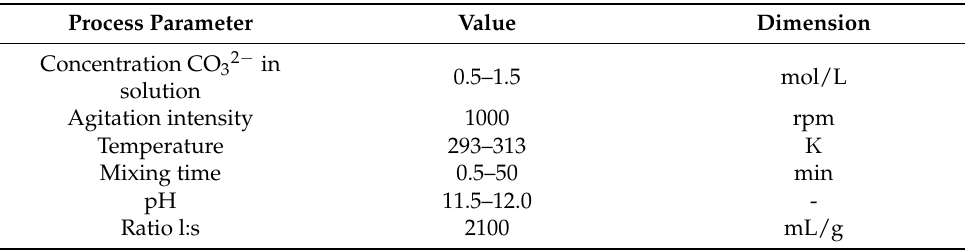
Table 3. Parameters of sediment carbonation of REM.